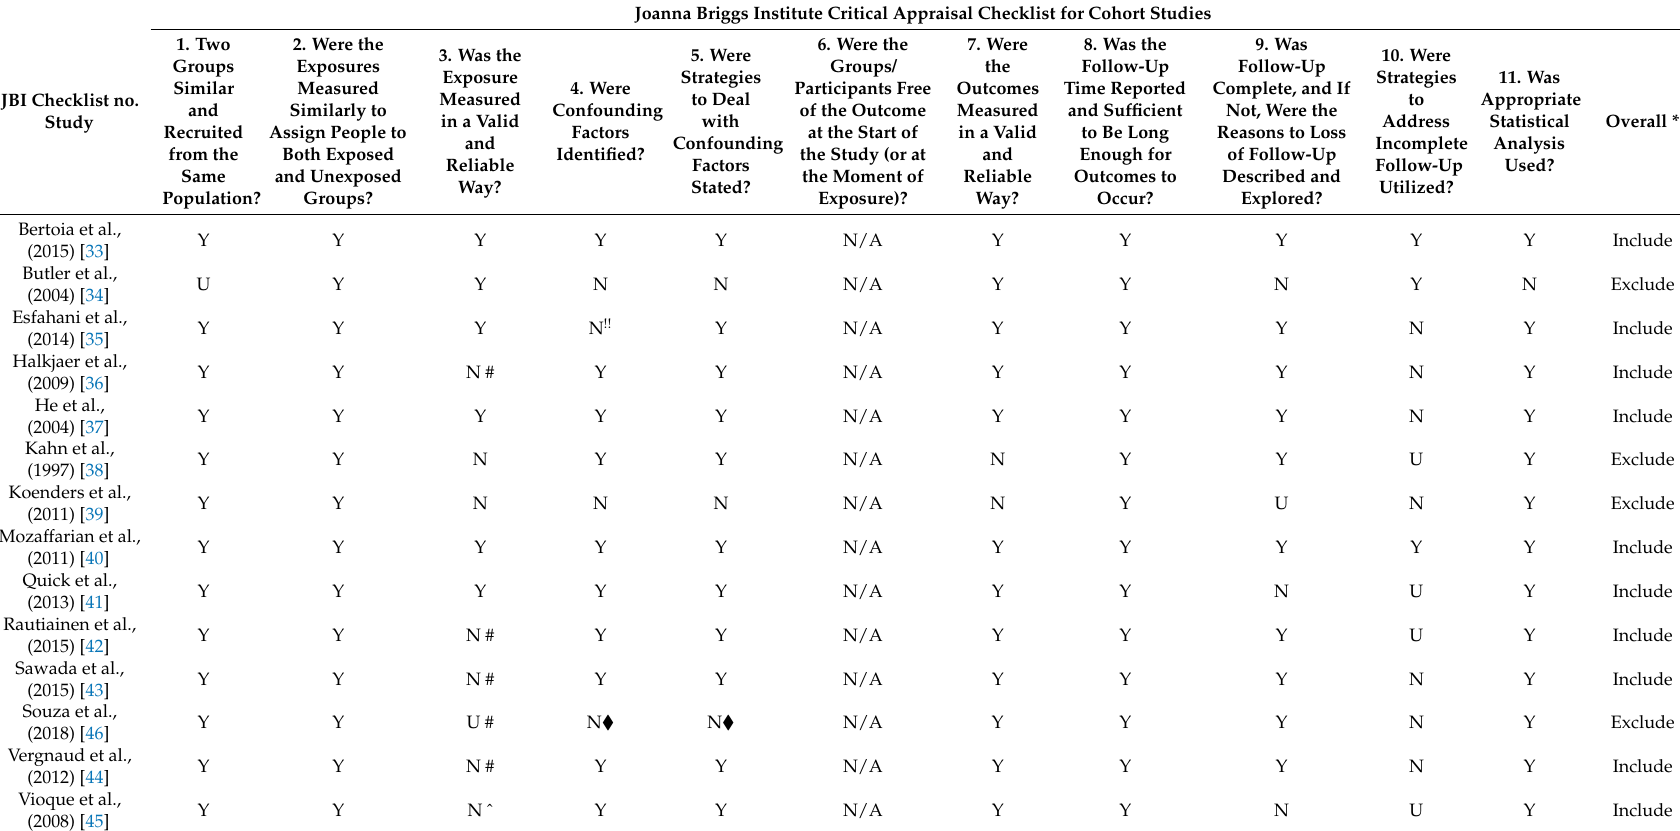
Table 2. Quality assessment using the Joanna Briggs Institute (JBI) Critical Appraisal Checklist for Cohort